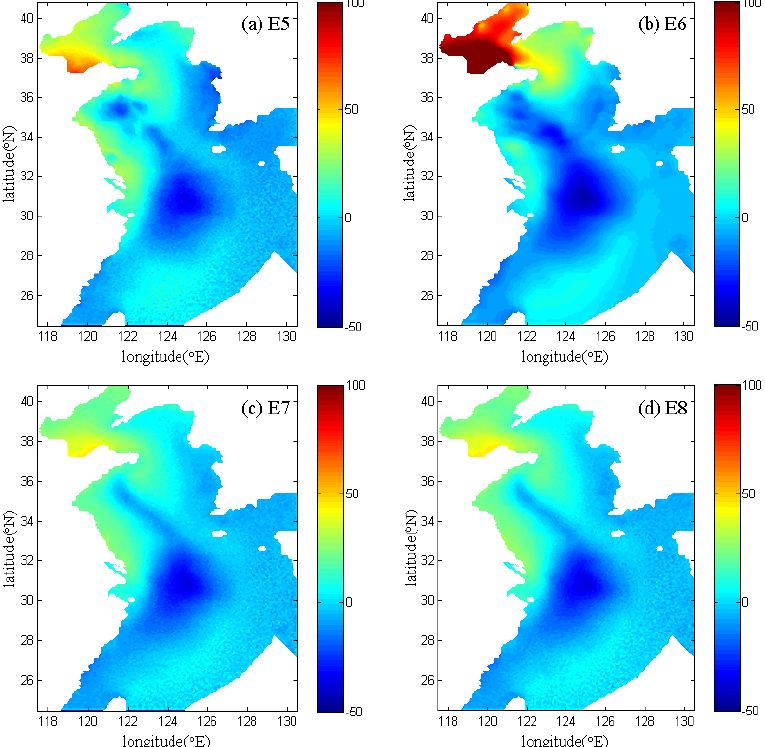
Figure 9. Spatially distributed levels calculated by the pure storm surge model in E5 – E8 at 20:00 a.m. on 19 July 1973 during Typhoon 7303.